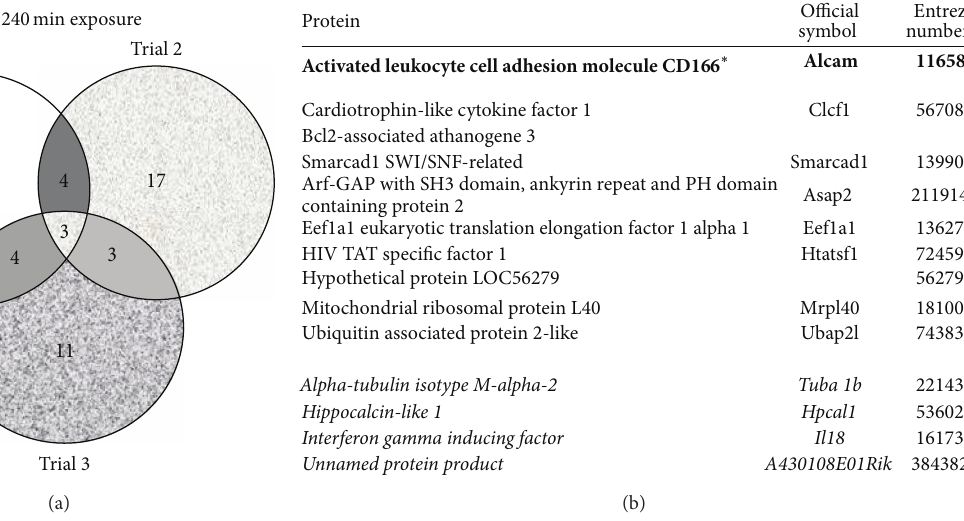
Figure 5: TCDD 240-minute treatment data set. (a) Venn diagram of proteins identified by mass spectrometry in 3 data sets of AHR-TAP 240 min TCDD (10nM) dosing. (b) Table listing of proteins identified in two out of three data sets. Bold type with ∗ denotes a protein represented in all three data sets. Italicized type denotes nonspecific proteins identified in both AHR-TAP and GFP-TAP samples.